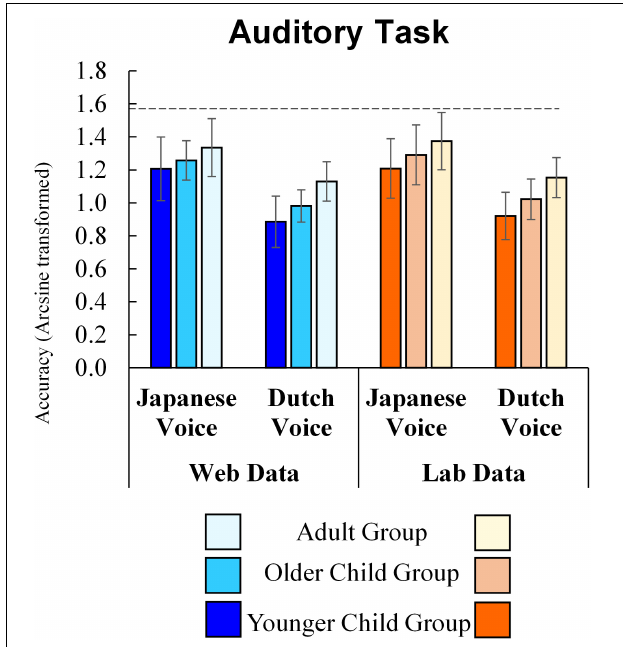
FIGURE 3 | Auditory task Accuracy (Error bars indicate standard deviations and a dashed line indicates a perfect score).